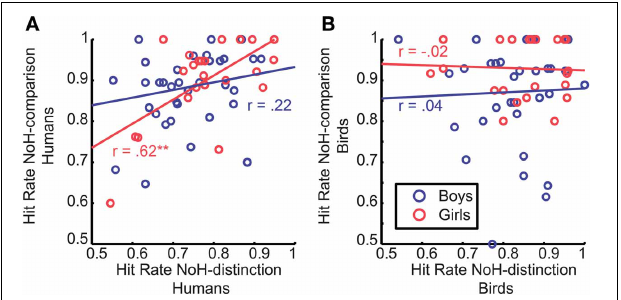
FIGURE 7 | Correlation of hit rates between the two need-of-help recognition paradigms. Data is shown separately for human- (A) and bird-depictions (B) . Each data point corresponds to the mean values for one child. Red circles refer to girls, blue ones to boys. Red and blue regression lines and adjacent correlation coefficients refer respectively to data of girls and boys. The asterisk indicates the significant Pearson correlation; ∗∗ p < 0 . 01. Regression lines were created using MatLab